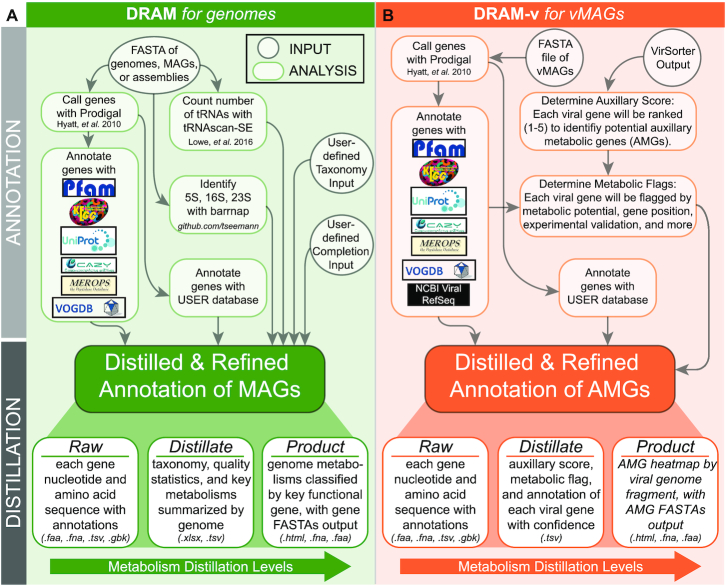
Conceptual overview and workflow of the assembly-based software, DRAM (Distilled and Refined Annotation of Metabolism). DRAM (green, A) profiles microbial metabolism from genomic sequences, while DRAM-v profiles the Auxiliary Metabolic Genes (AMGs) (orange, B) in vMAGs. DRAM’s input data files are denoted by circles in gray, while analysis and output files are denoted by rectangles in green for MAGs or orange for AMGs. DRAM’s outputs (from the Raw, Distillate and Product) provide three levels of annotation density and metabolic parsing. More details on the output files and specific operation can be found in the Supplementary Text or at https://github.com/shafferm/DRAM/wiki. User defined taxonomy (e.g. GTDB-Tk (24)) and completion estimates (e.g. CheckM (51)) for MAGs and isolate genomes can be input into DRAM.